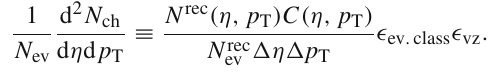
Fig. 1 The detector response for spherocity for two track multiplicity classes: (cid:3) d N m / d η (cid:4) = 3 . 12 (left) and (cid:3) d N m / d η (cid:4) = 25 (right). Proton- proton collisions were simulated using PYTHIA 6. The simulations include the particle transport performed via a GEANT 3 simulation of the ALICE detector. The markers (boxes around the points) indicate